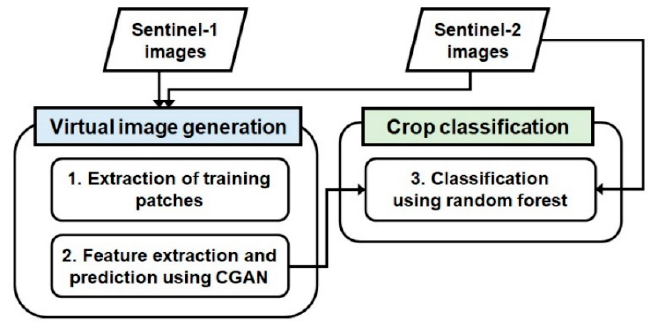
Figure 4. Schematic diagram of the processing flow applied in this study.